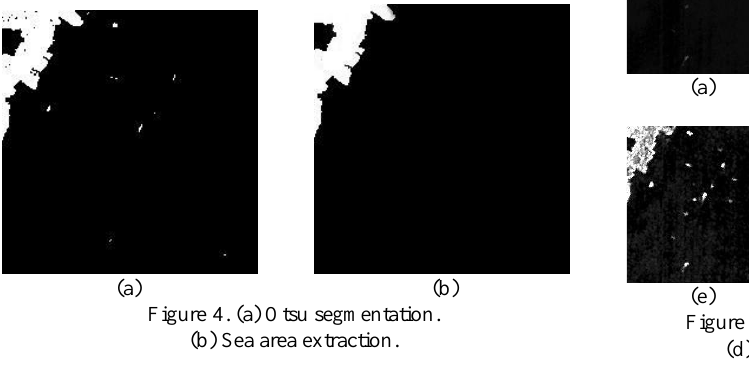
Figure 5. (a) Mean. (b) Variance. (c) Homogeneity. (d) Contrast. (e) Dissimilarity. (f) Entropy. (g) Second moment. (h)